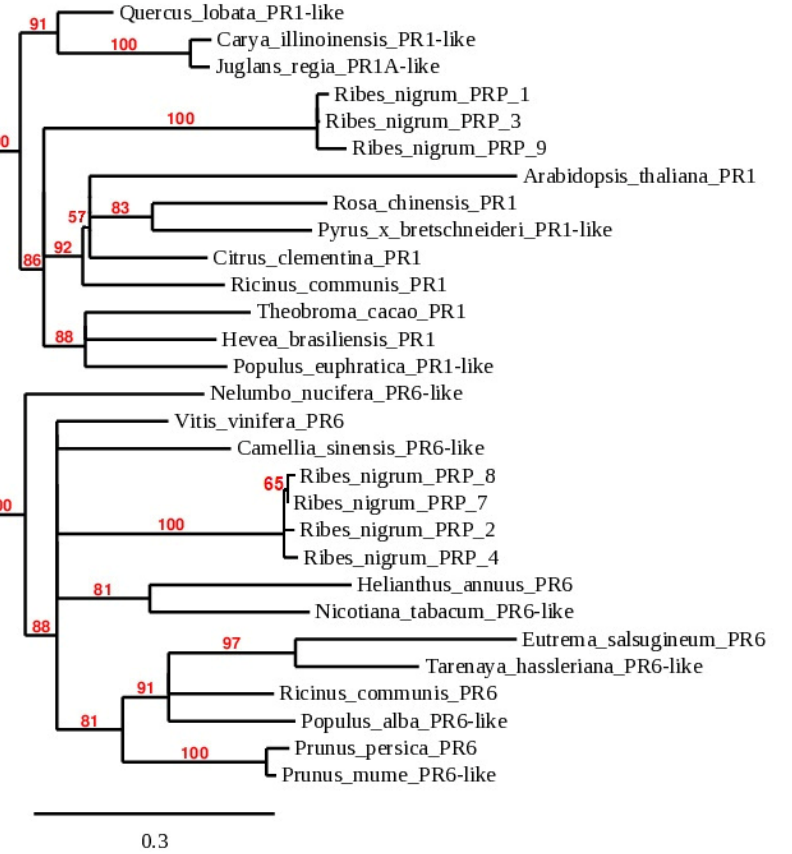
Figure 4. Phylogenetic dendrogram of PR genes constructed according to nucleotide sequences of 22 plant species. Accession numbers of newly obtained PR sequences of R. nigrum in our research are OK625407–OK625413 (Table S5); accession numbers of other plants in Figure 4 are available in Table S2.